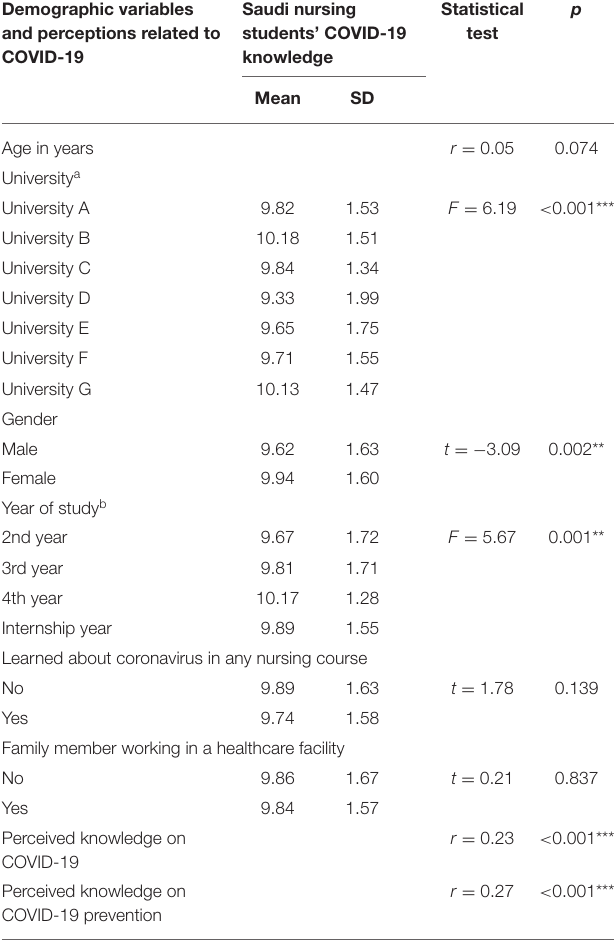
TABLE 3 | Results of the tests of associations between the Saudi nursing students’ COVID-19 knowledge and demographic variables and perceptions related to COVID-19 (n =